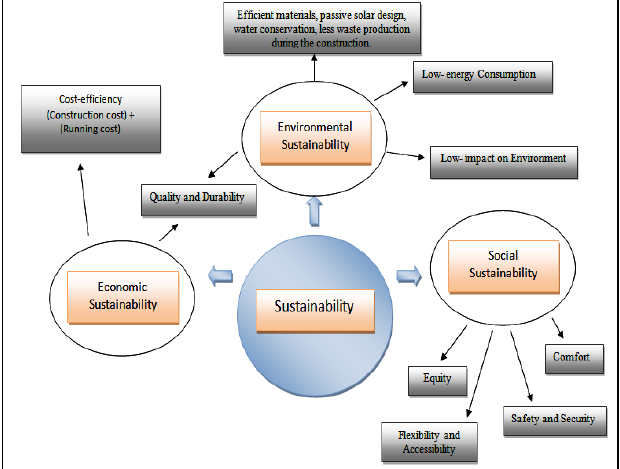
Figure 3. Assessments of sustainability three dimensions based on their factors. (By Auther). Source: (McConville, 2006; Abidin, and Jaapar, 2008; Zainul Abidin and Pasquire, 2005; Muhy Al-Din, et al., 2017;.Asif et al., 2005; Sani and Chi munaaim, 2012; Dell’Isola and Stephen, 1981; Minke, 2006; Koenigsberger, et al., 2010; Jin Kim, 1998; American Institute of Architects, 1992; Ilberg, and Rollins, 2007; Pullen et al., 2009)